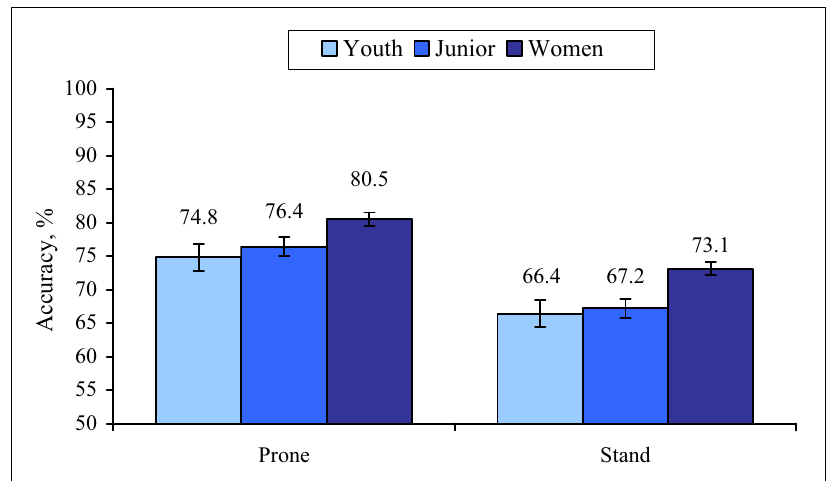
Figure 1. Shooting accuracy of various age group women biathletes, in prone and stand